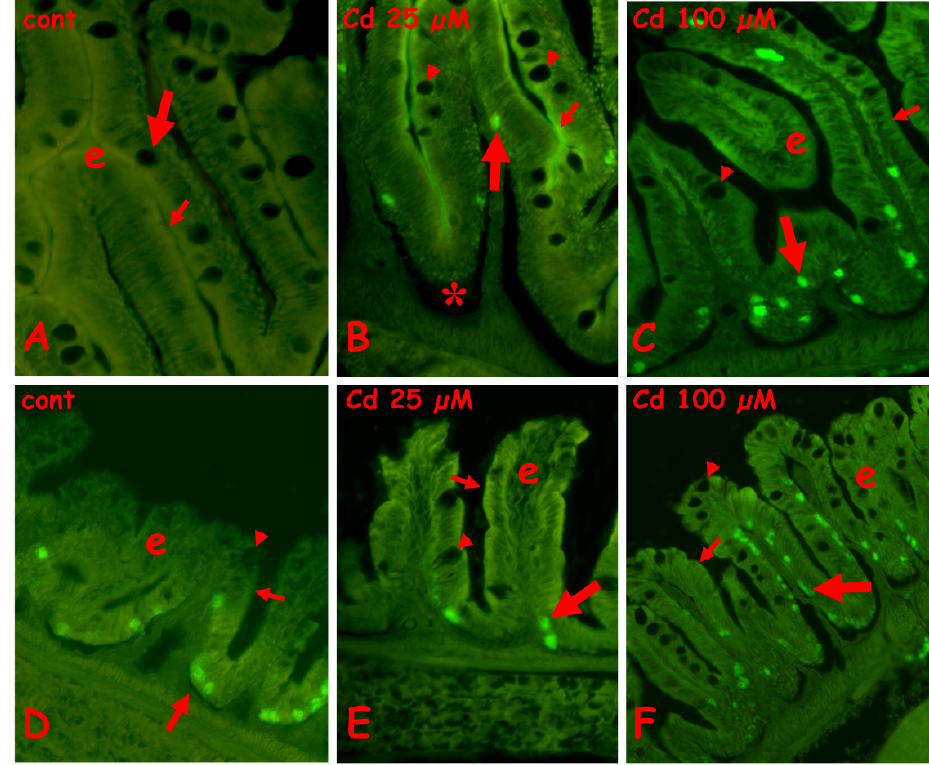
Figure 5. Effects of cadmium exposure on gut cells carbohydrate composition: staining for galactose with fluorescent lectin PNA. Anterior ( A – C ) and mid ( D – F ) gut. ( A ) Unlabeled enterocytes (e), goblet cells (large arrow), and brush border (small arrow). ( B ) Labeled brush border (small arrow) and scattered epithelial cells located at the base of the epithelium (large arrow). Note the seric infiltrate (*) and the unlabeled goblet cells (arrowheads). ( C ) Scattered labeled epithelial cells (large arrow) among unlabeled enterocytes (e), goblet cells (arrowhead) and brush border (small arrow). ( D – F ) Labeled cells (large arrows) in basal epithelium. Unlabeled enterocytes €, brush border (small arrow), and goblet cells (arrowhead). In ( F ), note the abundance of labeled cells.